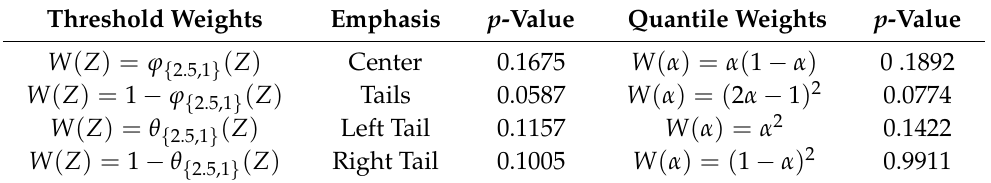
Table 7. Weighted CRPS tests for density forecasts for the extreme time-varying process. The density + 1 ) is estimated under the correct model assumption. Its competitor forecast ^ ˆ f t + 1 = N ( 0, ˆ σ 2 t + 1 ) uses a deliberately misspecified predictive variance. The width of the sliding ˆ g t + 1 = N ( 0,1ˆ σ 2 t training window is m = 76, and n = 128 one-step-ahead density forecasts is considered.